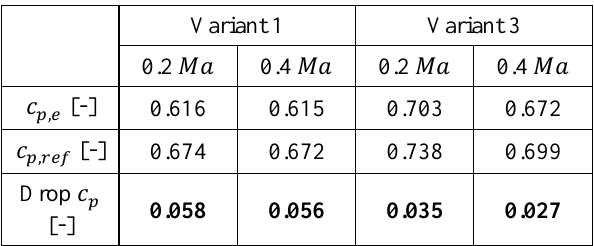
Fig. 16. Variant with all struts – Variant 𝑒 . Table 7. Pressure recovery coefficient values – all